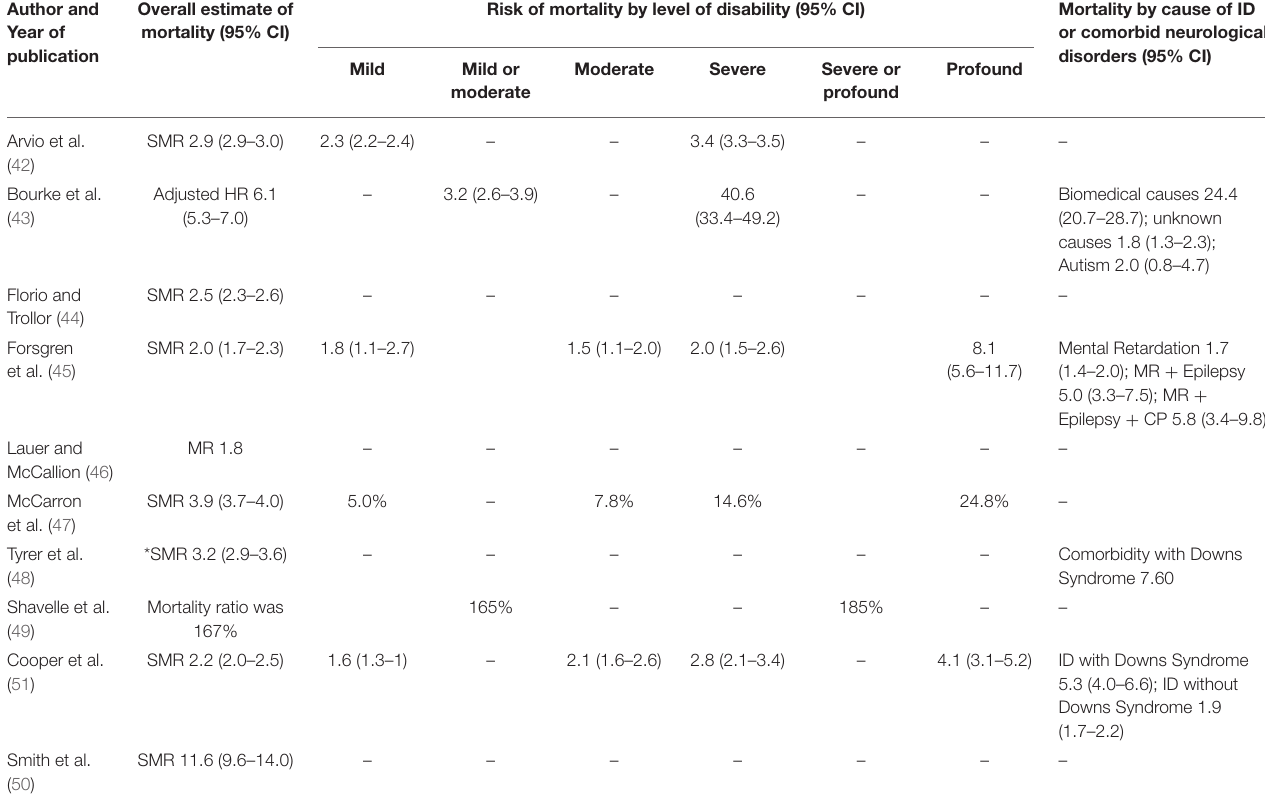
TABLE 5 | Mortality by severity and aetiology of intellectual